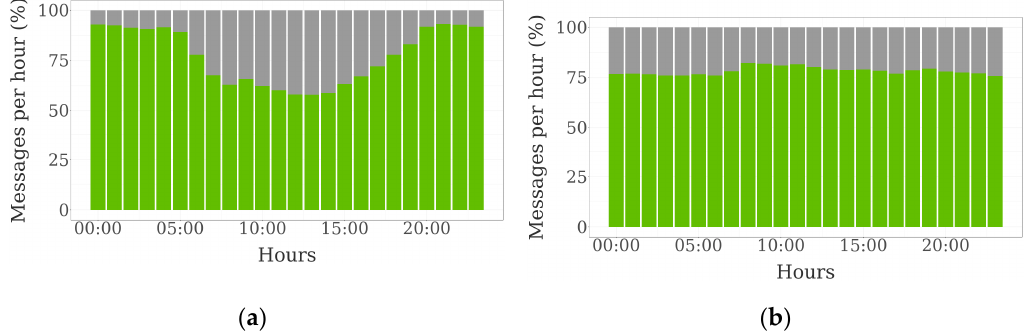
Figure 7. Hourly evolution of the percentage of collar messages with (green) and without (grey) tag data (25 collars and 25 tags): ( a ) sheep farm; and ( b ) beef cattle farm.